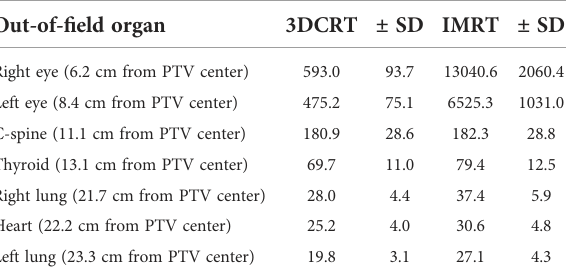
TABLE 5 Mean dose measured by TLDs in out-of- fi eld organs. Mean dose measured by TLDs (mGy) and corresponding standard deviation (SD, in